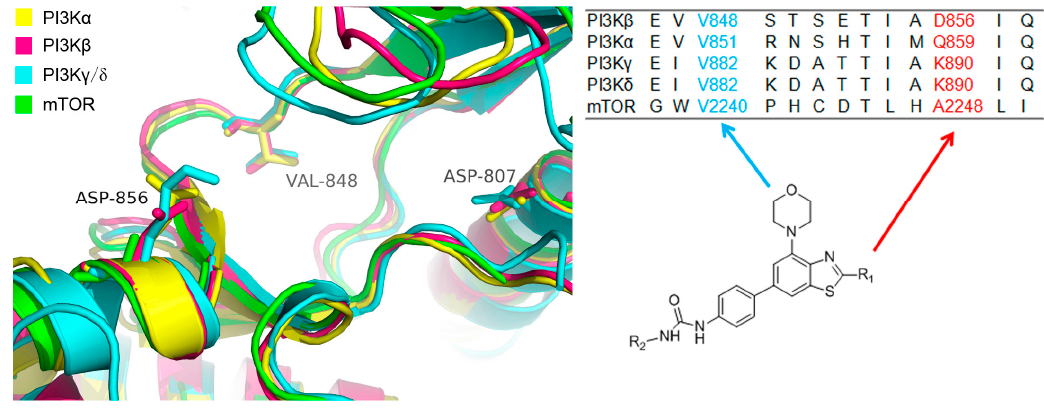
Figure 2. ( Left ): structure superimposed of PI3K α , β , γ , δ and mTOR. Red: PI3K β (4BFR), yellow: PI3K α (3ZIM), blue: PI3K γ (5EDS) or PI3K δ (4GB9), green: mTOR (4JT6); ( Right ): part of the sequence alignment